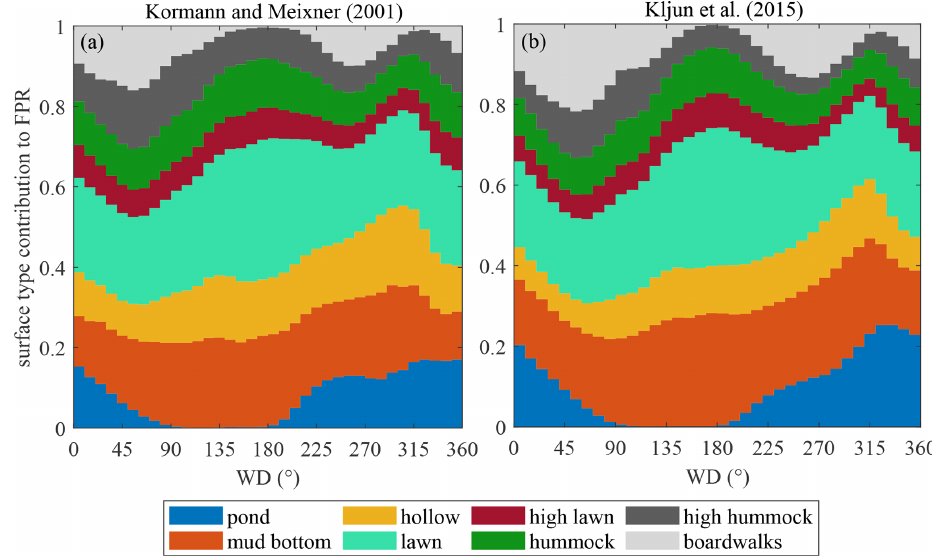
Figure 8. Surface type contributions to surface exchange versus wind directions, presented as means over 10 ◦ Wind direction (WD) bins using all available data.